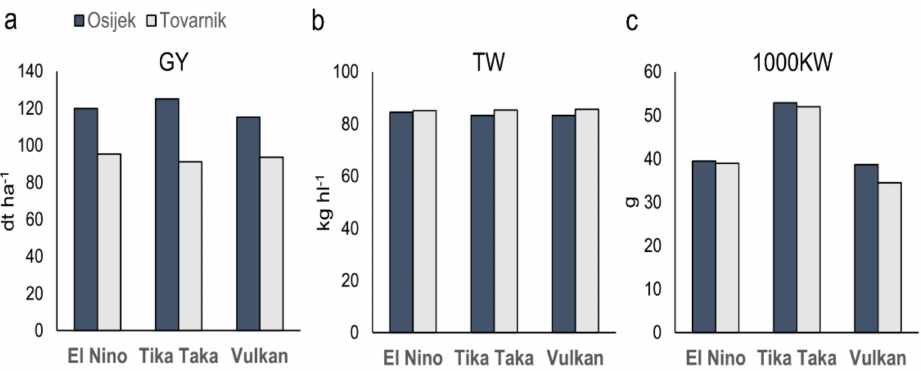
Figure 2. Grain yield (GY) (dt ha − 1 ) ( a ), test weight (TW) (kg hl − 1 ) ( b ), and 1000 kernel weight